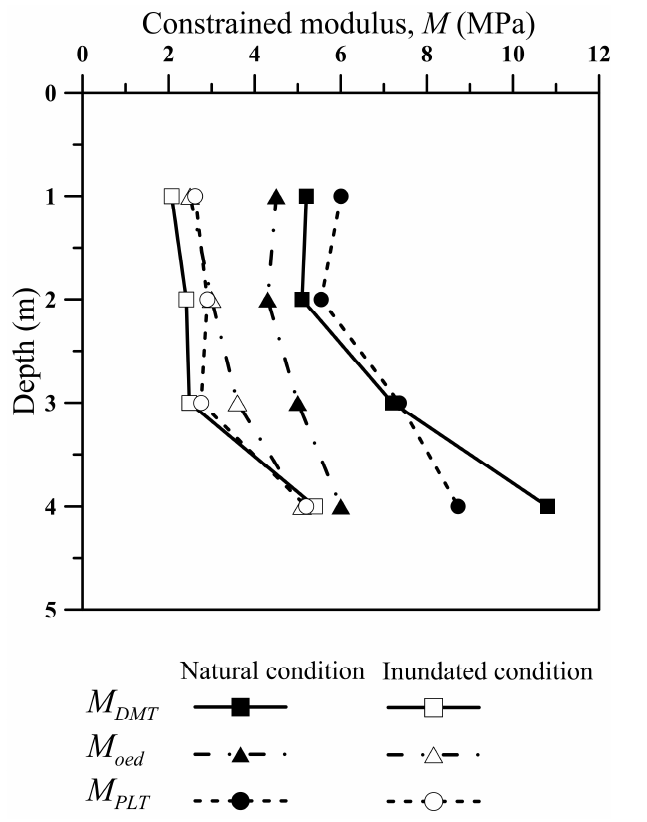
Figure 10. Constrained modulus values determined from the DMT, oedometer test and PLT, under natural and inundated condition for the study site. Table 3. M DMT values for the natural and inundated condition and the reduction observed on this parameter.